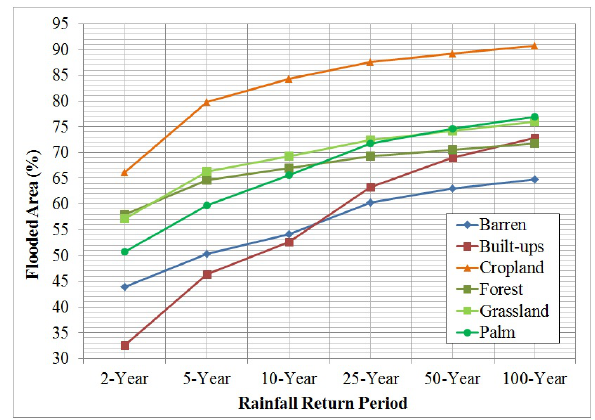
Figure 12: Percentage of flooded land-cover class for each of the 6 extreme rainfall